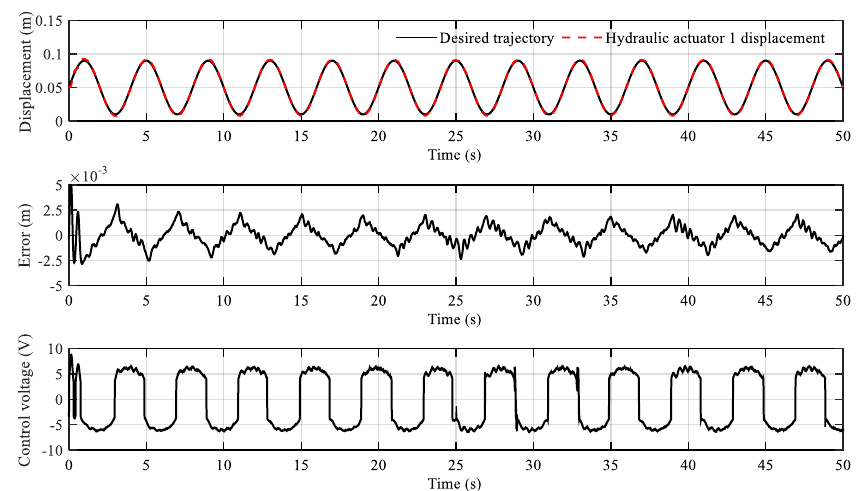
Figure 9. Sinusoidal trajectory tracking curve of hydraulic actuator 1.